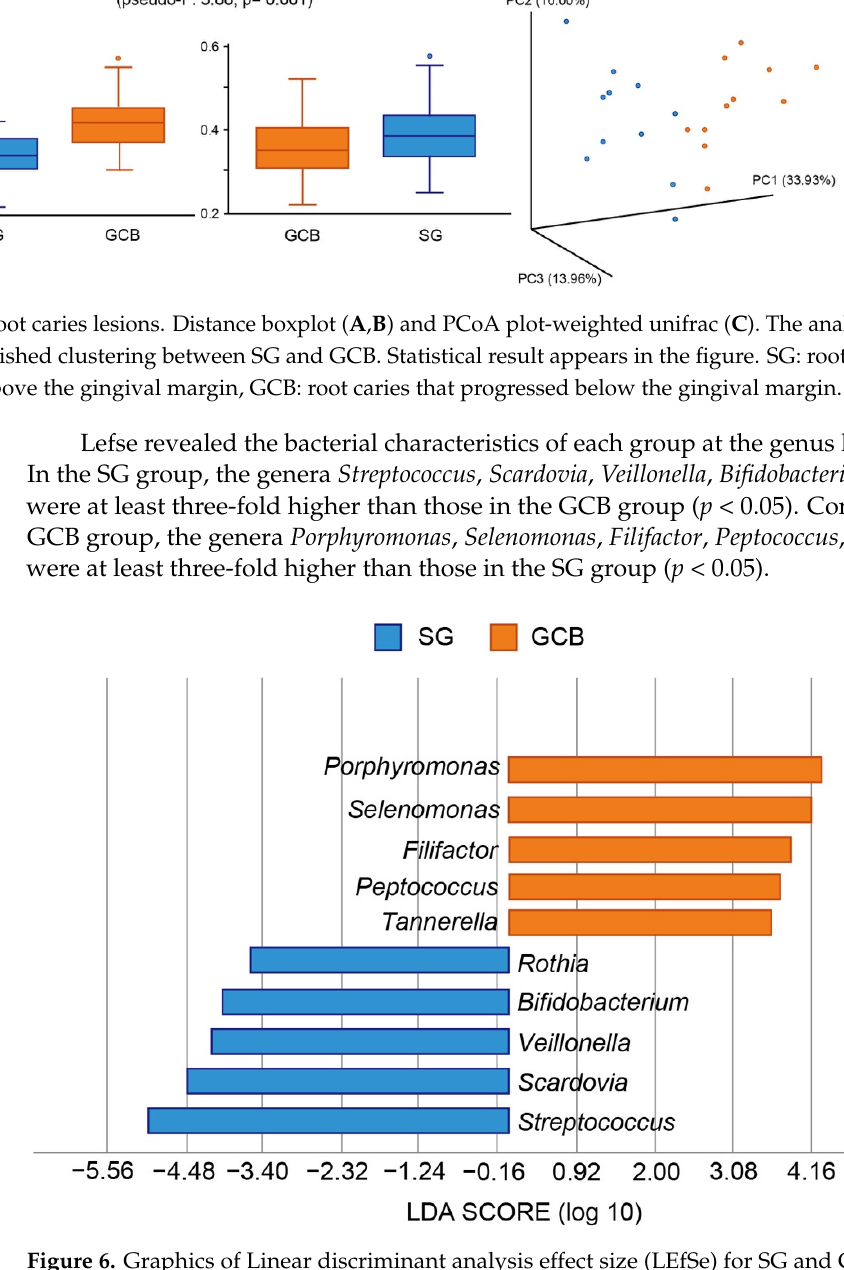
Figure 6. Graphics of Linear discriminant analysis effect size (LEfSe) for SG and GCB. Horizontal bars represent the effect size for each taxon. The length of the bar represents the log 10 transformed LDA score, indicated by vertical dotted lines. The threshold on the logarithmic LDA score for discriminative features is set to 3.0. The taxon of bacteria with statistically significant change ( p < 0.05) in the relative abundance is expressed alongside the horizontal lines. SG: root caries that existed independently above the gingival margin, GCB: root caries that progressed below the gingival